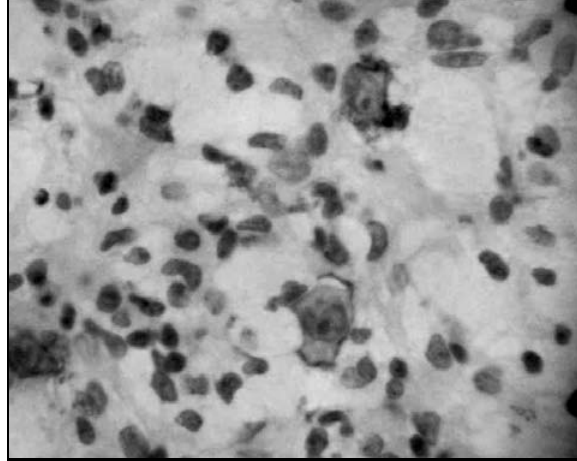
Figura – Células Reed-Sternberg marcadas pelo CD